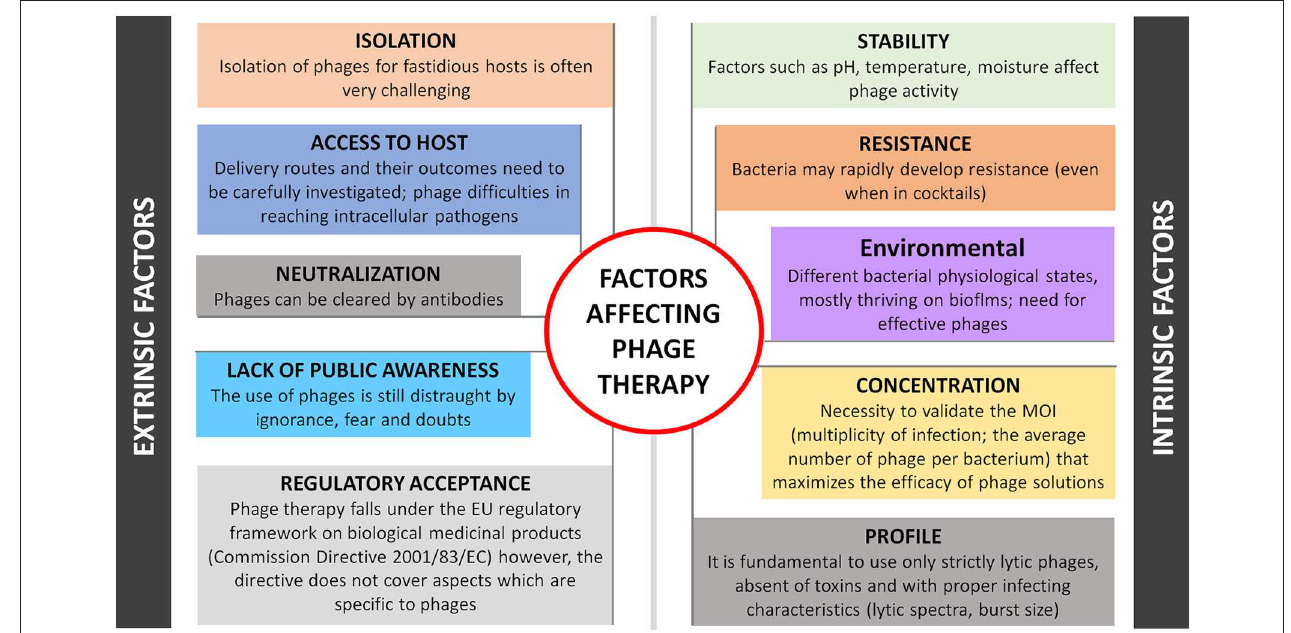
FIGURE 1 | Schematic representation of factors that limit phage